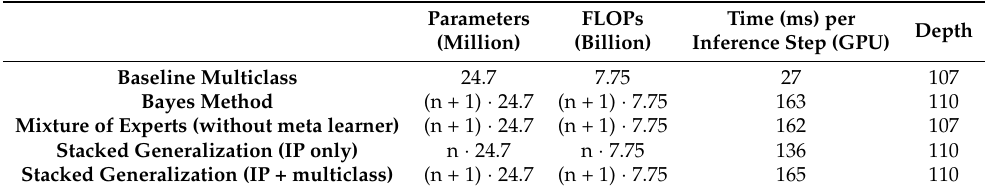
Table 2. Specification comparison of every proposed architecture in terms of parameter count, FLOPs, inference time, and depth .